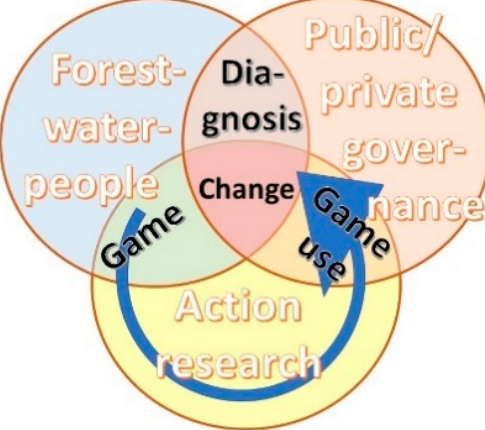
Figure 2. The three spheres in which SESAM will operate to ensure credible (based on current understanding), salient (actionable in terms of public and/or private governance) and legitimate (aligned with stakeholder interests) games, used appropriately.